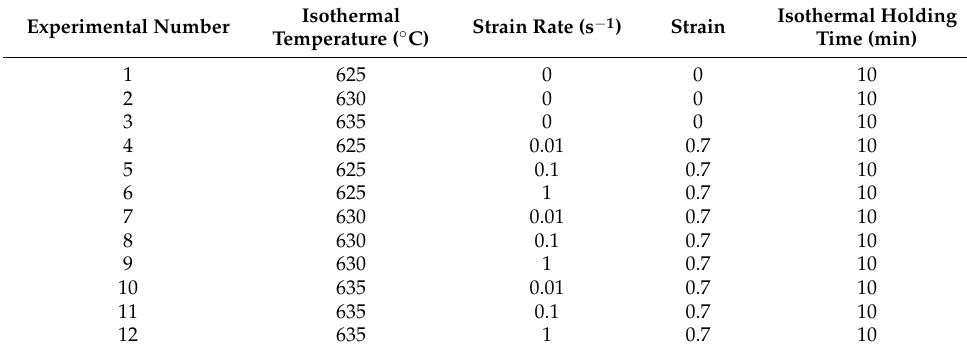
Table 2. Experimental process parameters.